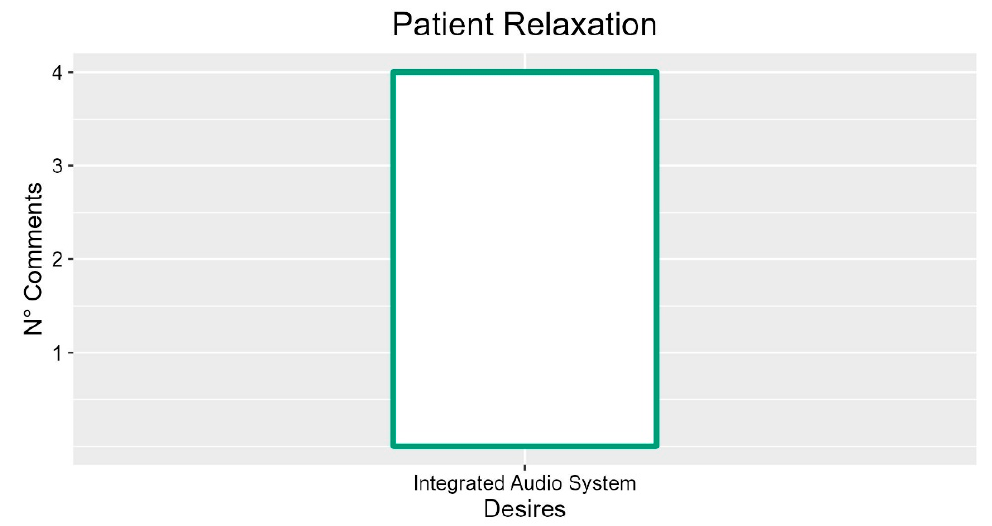
Figure 17. Graphical representation of desire with more occurrences for the Patient Relaxation theme.